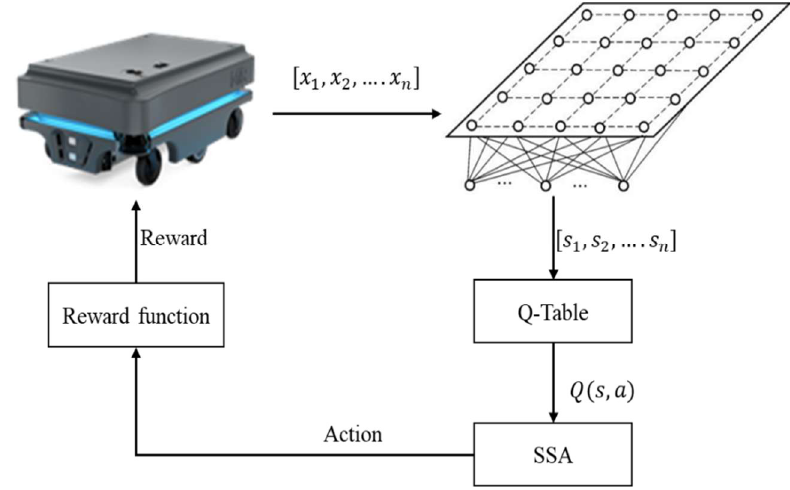
Figure 2. Algorithm flow chart.